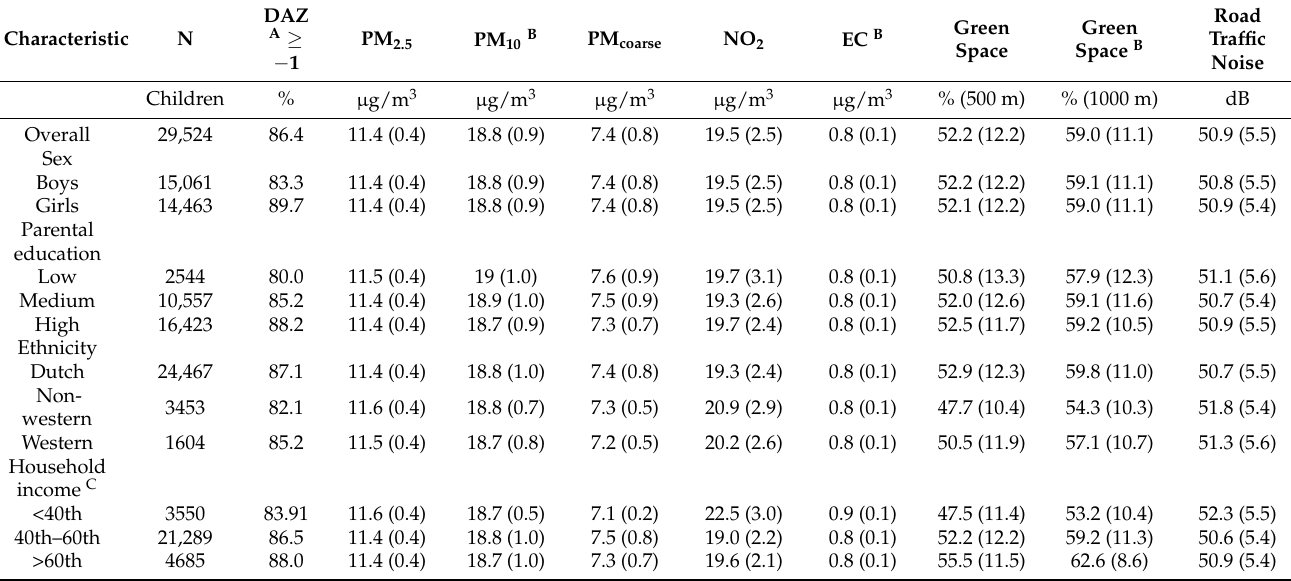
Table 2. Environmental factors and DAZ stratified per sex, ethnicity, parental education, and household income. Values are arithmetic means (standard deviation) unless stated otherwise. N represents the number of children